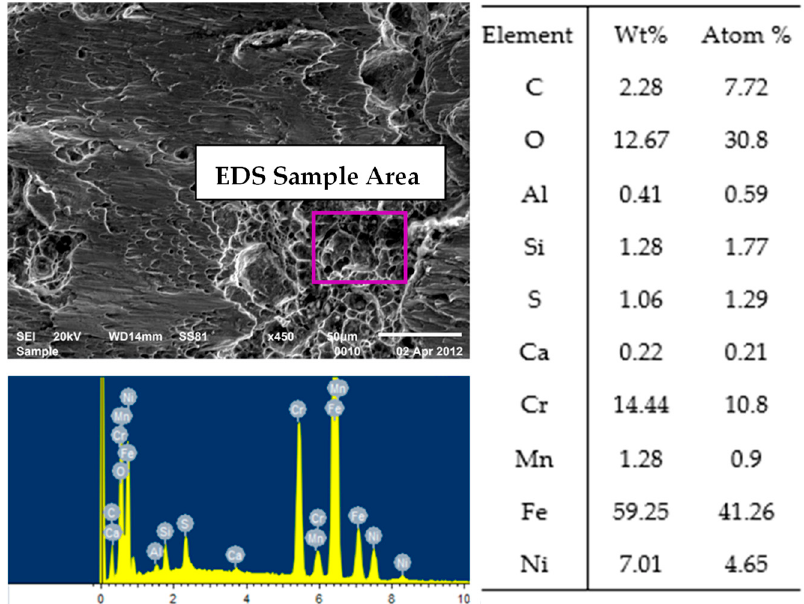
Figure 6. Energy Dispersive Spectroscopy (EDS) results of the fracture surface.